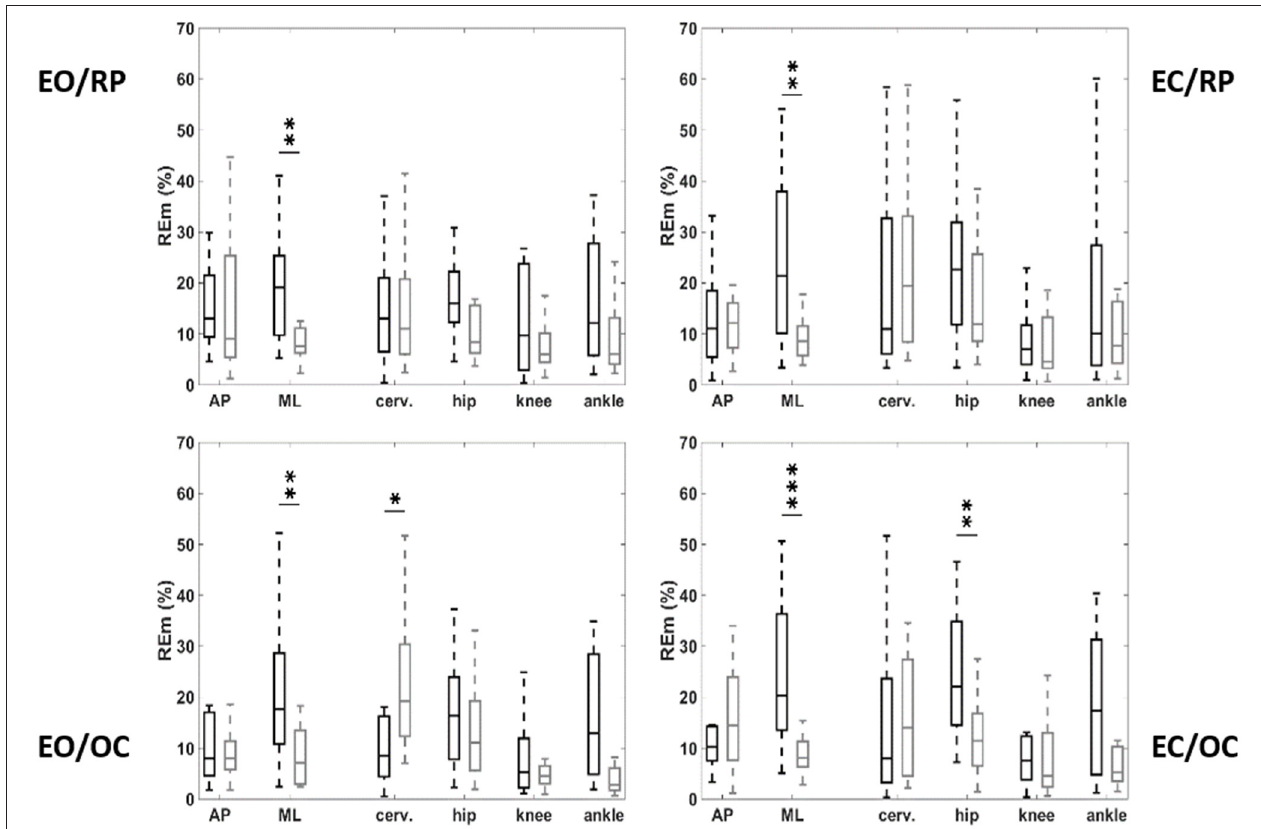
FIGURE 3 | Respiratory emergence on antero-posterior (AP) and mediolateral (ML) deplacement of the center of pressure, and variation of kinematic angle at the level of the cervical spine, pelvis, knees, and angles, as function of vision and occlusion. OSAS patients (black), controls (gray). EO, eyes open; EC, eyes closed; OC, mandible positioned by occlusion of the teeth; RP, mandible positioned by the muscles without occlusion. * p < 0.05; ** p < 0.01; *** p <